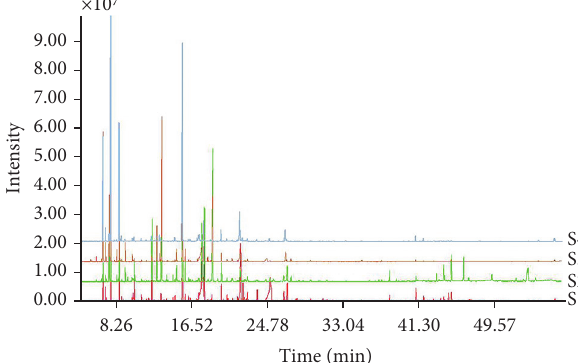
Figure 2: Representative total ion chromatograms of EOs of DHC1, DHC2, FHC1, and FHC2. S1: DHC1; S2: DHC2; S3: FHC1; S4: